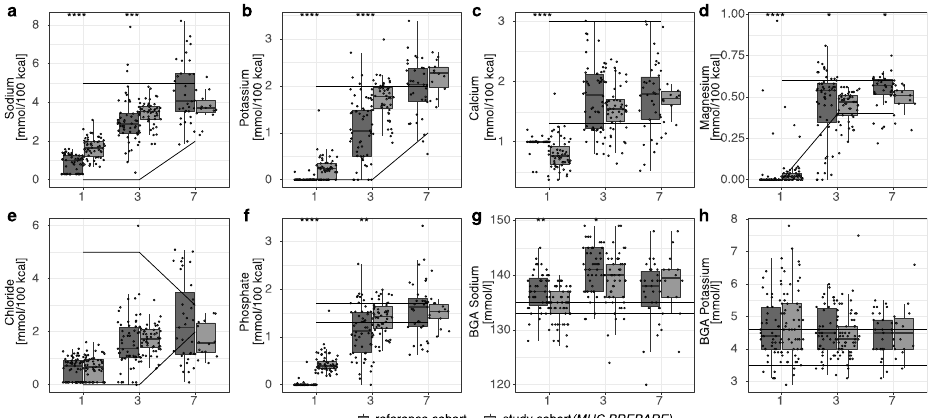
Figure 2. ( a – f ) Electrolyte supply in the parenteral diet regimens. ( g , h ) Serum levels of sodium and potassium. Recommendations shown as horizontal lines (ESPGHAN 2005 [24]). * p < 0.05, ** p < 0.01, *** p < 0.001, **** p < 0.0001. Study cohort ( MUC PREPARE ): 2012 – 2014, reference cohort: 2007 – 2009.